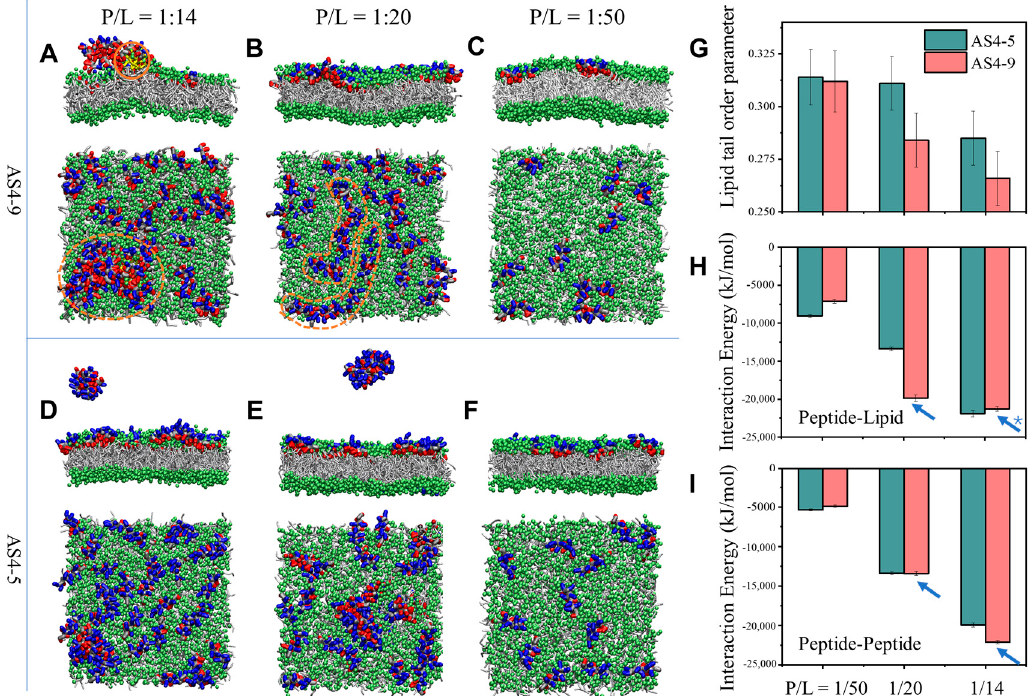
Figure 5. MD simulations of the interactions between peptides (i.e., AS4-5 and AS4-9) and a mem- brane (PC/PG = 7/3) at varying peptide/lipid (P/L) ratios. ( A – F ), representative snapshots. ( A – C ), AS4-9; ( D – F ), AS4-5. ( A , D ), P/L = 1/14; ( B , E ), P/L = 1/20; ( C , F ), P/L = 1/50. Green beads, lipid heads; silver lines, lipid tails. Blue and red colors refer to the hydrophilic and hydrophobic sides of the peptides, respectively. Dashed orange lines in ( A , B ) emphasize the aggregated or linear distribution of peptides. Solid orange circle in ( A ) refers to the extracted lipids (shown in yellow). ( G – I ) Histo- grams showing the order parameter of lipid chains ( G ) and the interaction energy between peptides and lipids ( H ) or between peptides ( I ) in different conditions. Blue arrows emphasize the stronger interaction energy for AS4-9 compared with AS4-5, and the asterisk indicates the influence of pep- tide aggregation. All the results were captured at 2 μ s after peptide addition.